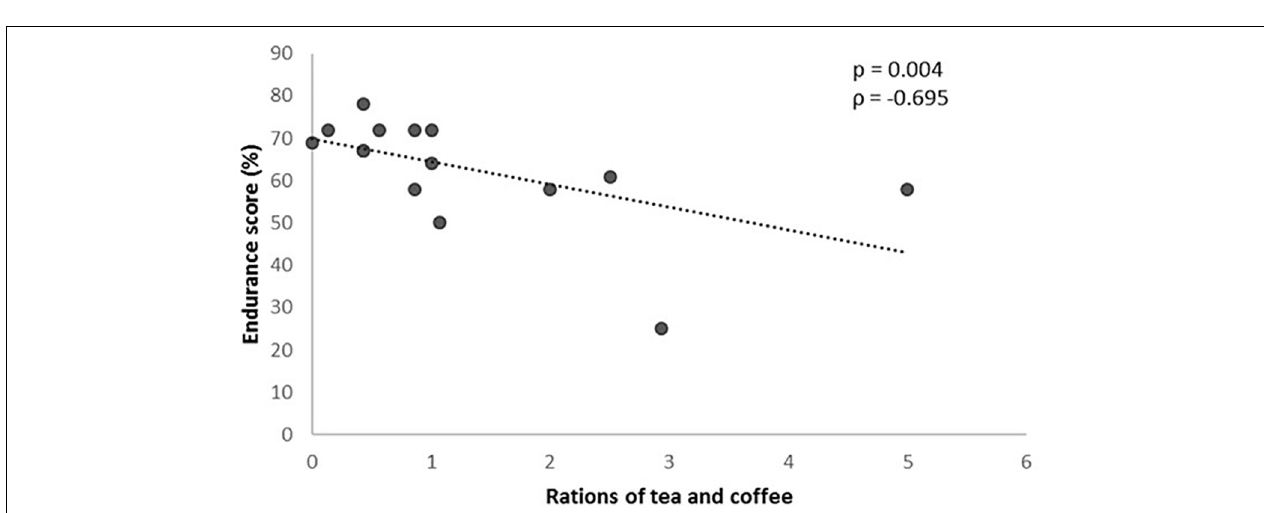
FIGURE 3 | Association of SNPs included in the prediction algorithm GES and specific dietary variables. (A) Consumption of% total caloric value (TCV) carbohydrates according to AQP1 rs1049305. (B) Consumption of% TCV sugars according to CKM rs8111989. (C) Mean glycemic index values according to ACE rs4343.